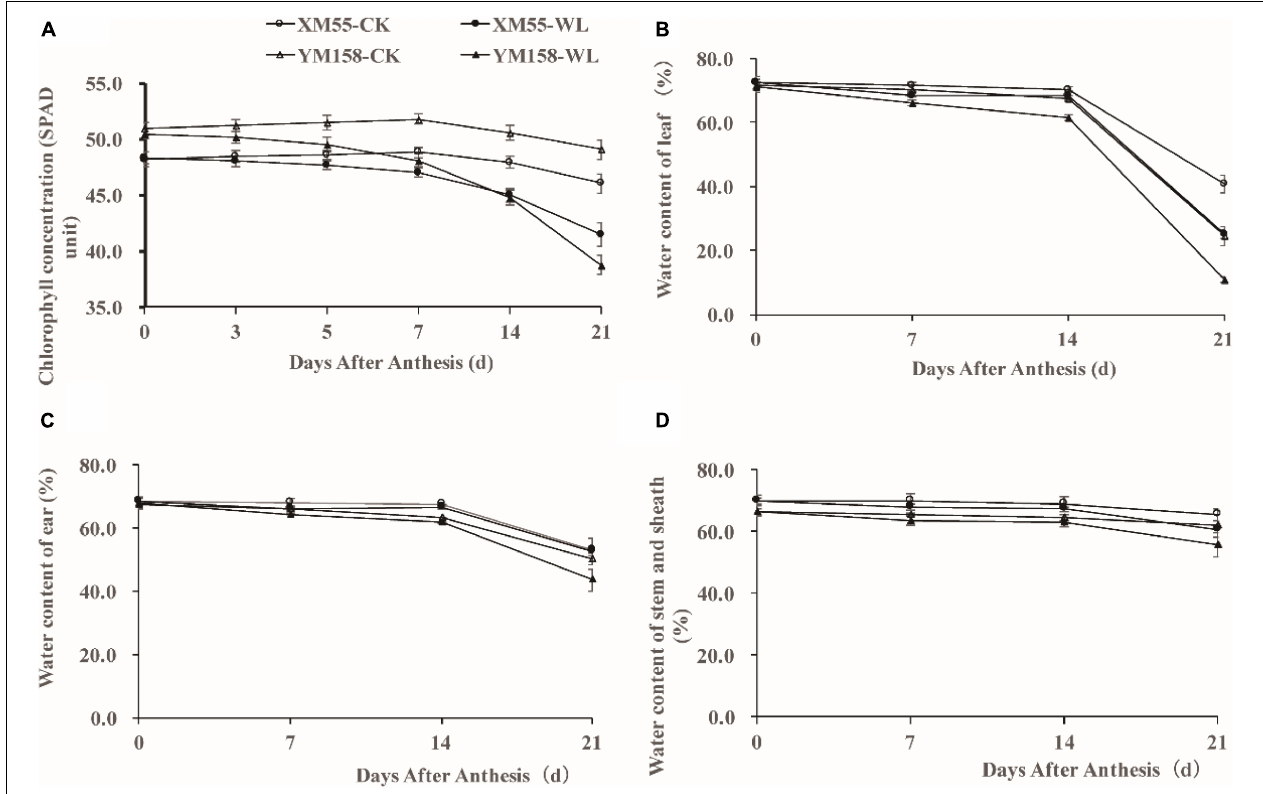
FIGURE 1 | Phenotypes of XM 55 and YM 158 under waterlogging and control conditions. (A) Dynamic changes of chlorophyll concentration (SPAD unit) of the last expanded leaf after 7 days waterlogging at anthesis. (B) Dynamic changes of water content of leaf after waterlogging at anthesis between different varieties. (C) Dynamic changes of ear water content after waterlogging at anthesis between different varieties. (D) Dynamic changes of water content of stem and sheath after waterlogging at anthesis between different varieties. Vertical bars indicate standard error of the mean ( n = 3).